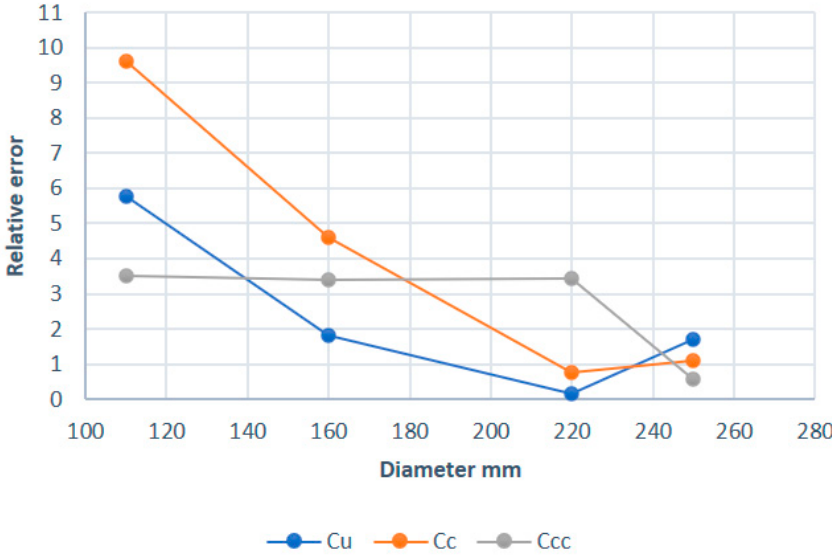
Figure 16. Relative error distribution for each diameter using the FE approach for all scenarios.